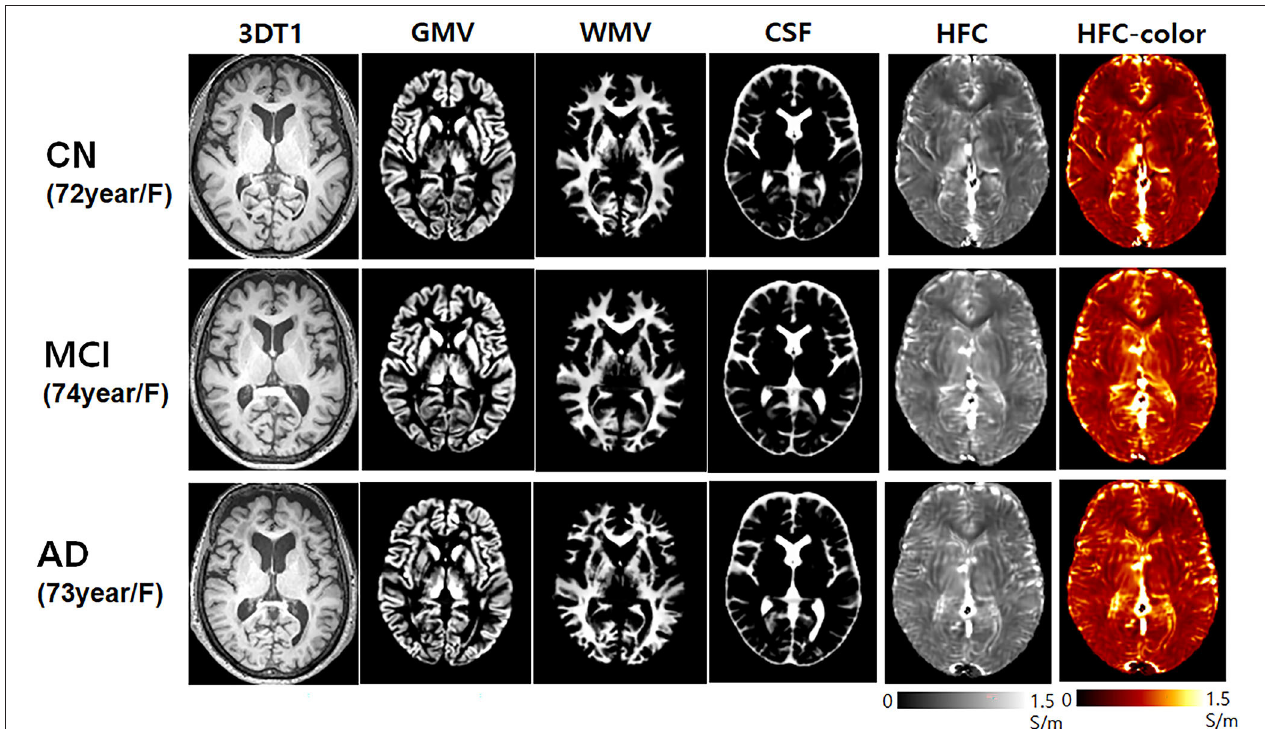
FIGURE 1 | Representative high-frequency conductivity (HFC) maps and the 3D T1-weighted image with the corresponding segmented brain tissue volumes of gray matter and white matter obtained from one cognitively normal (CN) elderly (72-year-old female), one mild cognitive impairment (MCI) (74-year-old female), and one Alzheimer’s disease (AD) (73-year-old female)